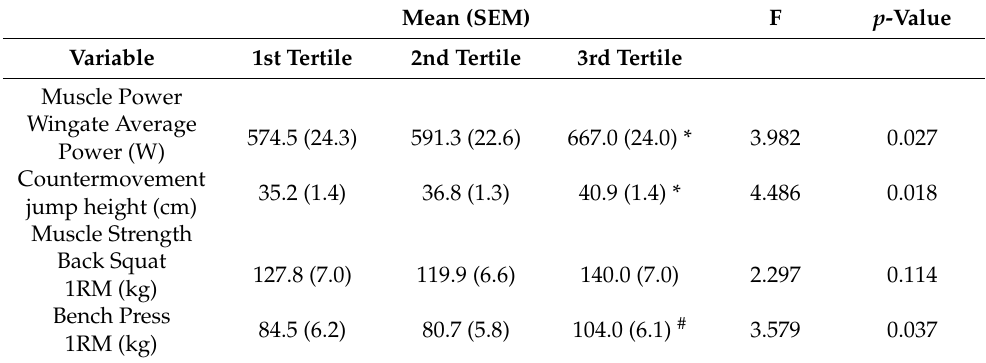
Table 2. Comparison of performance in muscle power and strength tests between PhA tertiles. Mean (SEM) F p -Value 1st